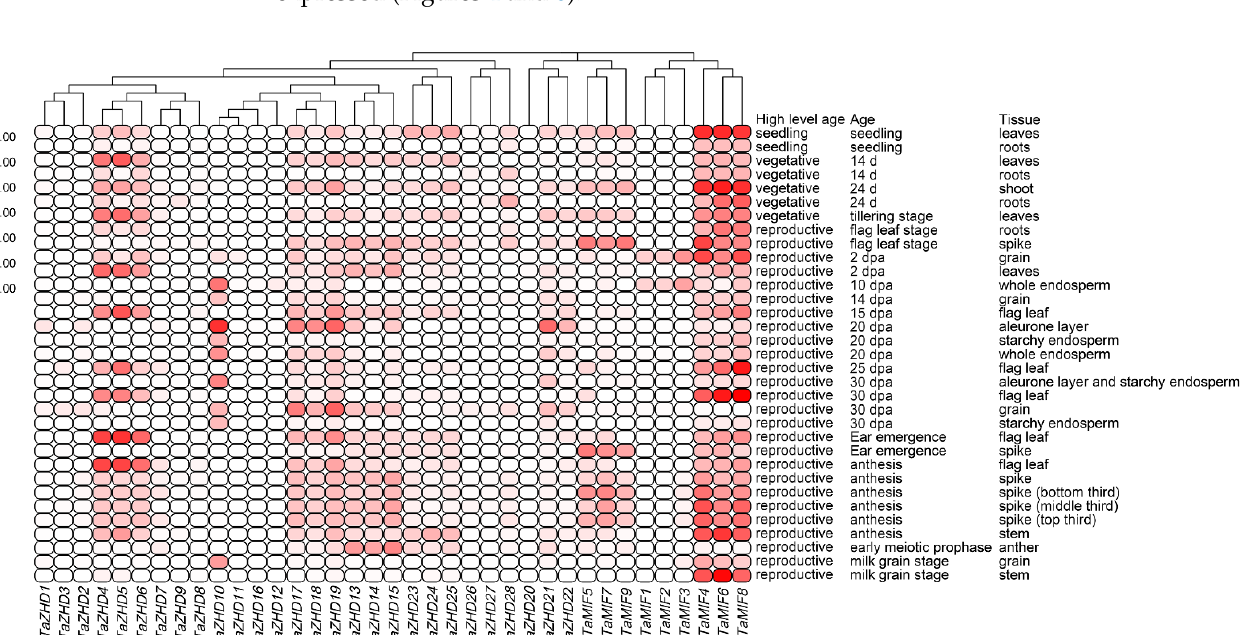
Figure 7. Expression levels of TaZF-HD genes in the roots, stems and leaves of wheat seedlings. The expression level of the wheat actin gene was used as the internal control to standardize the RNA samples for each reaction. The values are the